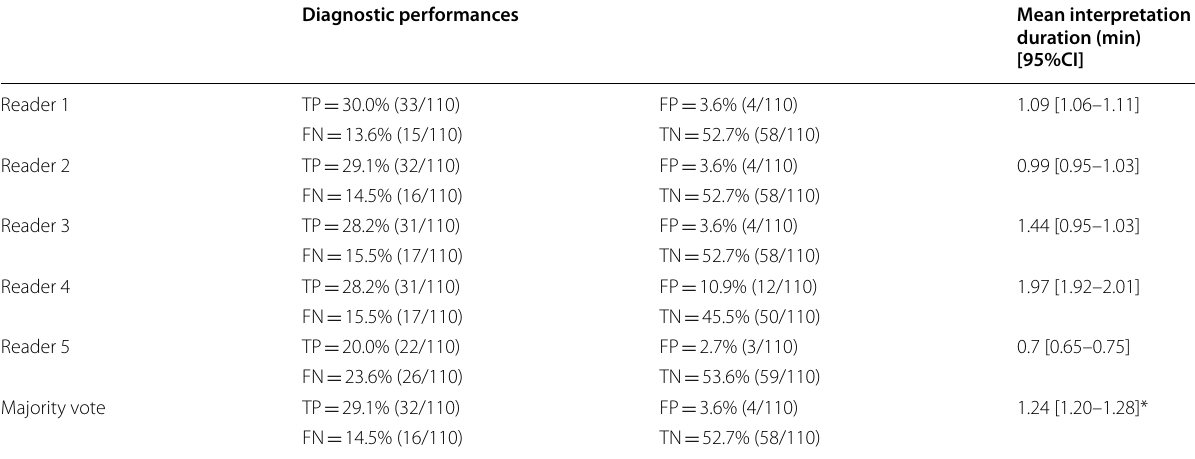
Mean interpretation time was expressed with 95% confidence interval [95%CI] TP true positive, FP false positive, FN false negative, TN true negative *Pooled mean interpretation duration across the five readers